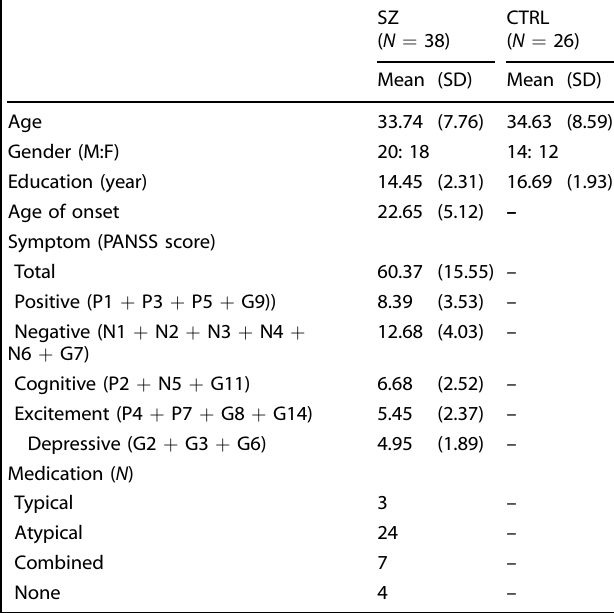
Table 2. Demographic information of the patients with schizophrenia (SZ) and the healthy control (CTRL)